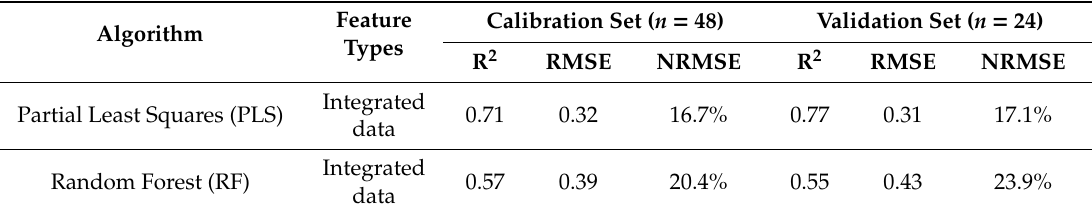
Table 7. Modeling results between comprehensive parameters and